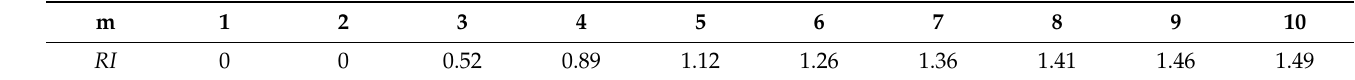
Table 2. The value of mean random consistency index RI